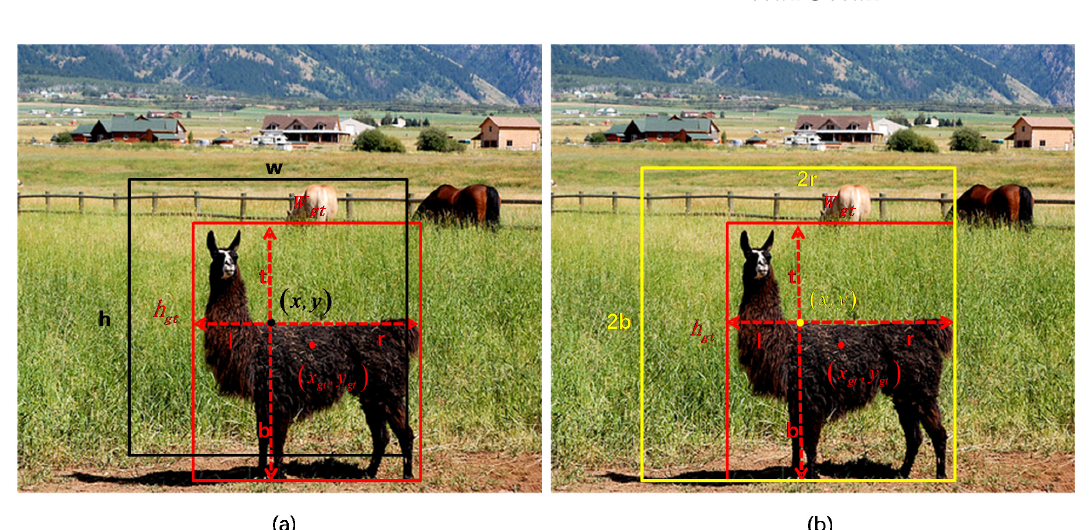
Figure 3. ( a ) The red box and the black box represent the ground-truth box (𝑥 (cid:3034)(cid:3047) ,𝑦 (cid:3034)(cid:3047) ,𝑤 (cid:3034)(cid:3047) ,ℎ (cid:3034)(cid:3047) ) and the corresponding pre-defined anchor ( x , y , w , h ) , respectively. ( x gt , y gt ) is the coordinate of the center point of the ground-truth box. w gt and h gt represent the width and height of the of the ground-truth box, respectively. l, t, r and b are the distances from the location ( x , y ) to the four sides of ground-truth box. The width w gt and height h gt are calculated by w gt = l + r and h gt = t + b ; ( b ) The yellow box ( x , y ,2 r ,2 b ) represents the best anchor box of box (cid:0) x gt , y gt , w gt , h gt (cid:1)